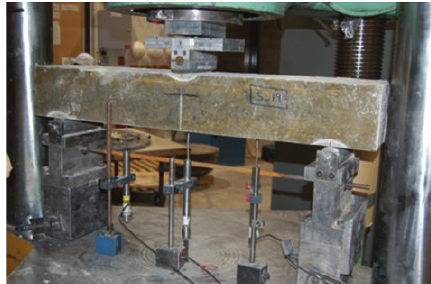
Figure 2: Beam test setup under quasi-static